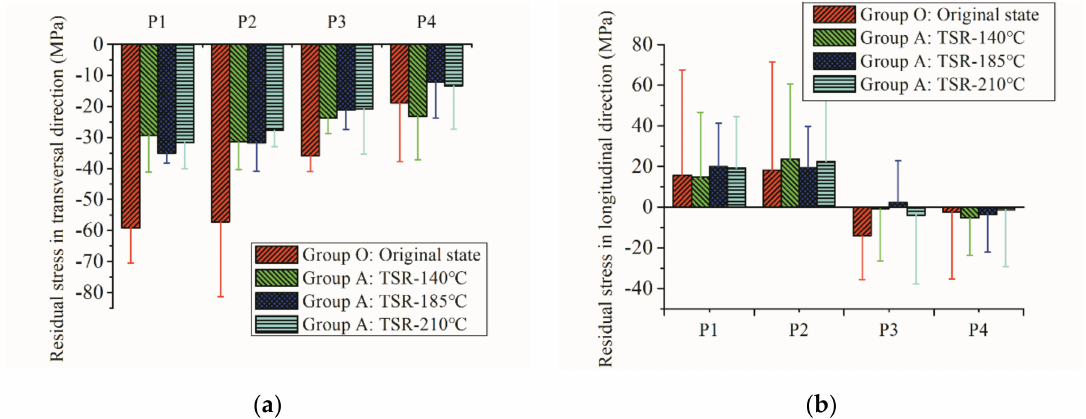
Figure 5. Residual stresses in the transversal direction ( a ) and longitudinal direction ( b ) at each measurement point, before and after thermal stress relief (TSR) treatment at different temperatures (each bar represents the average values along the depth direction, and the one with the largest amplitude among the six measured values is expressed by the error